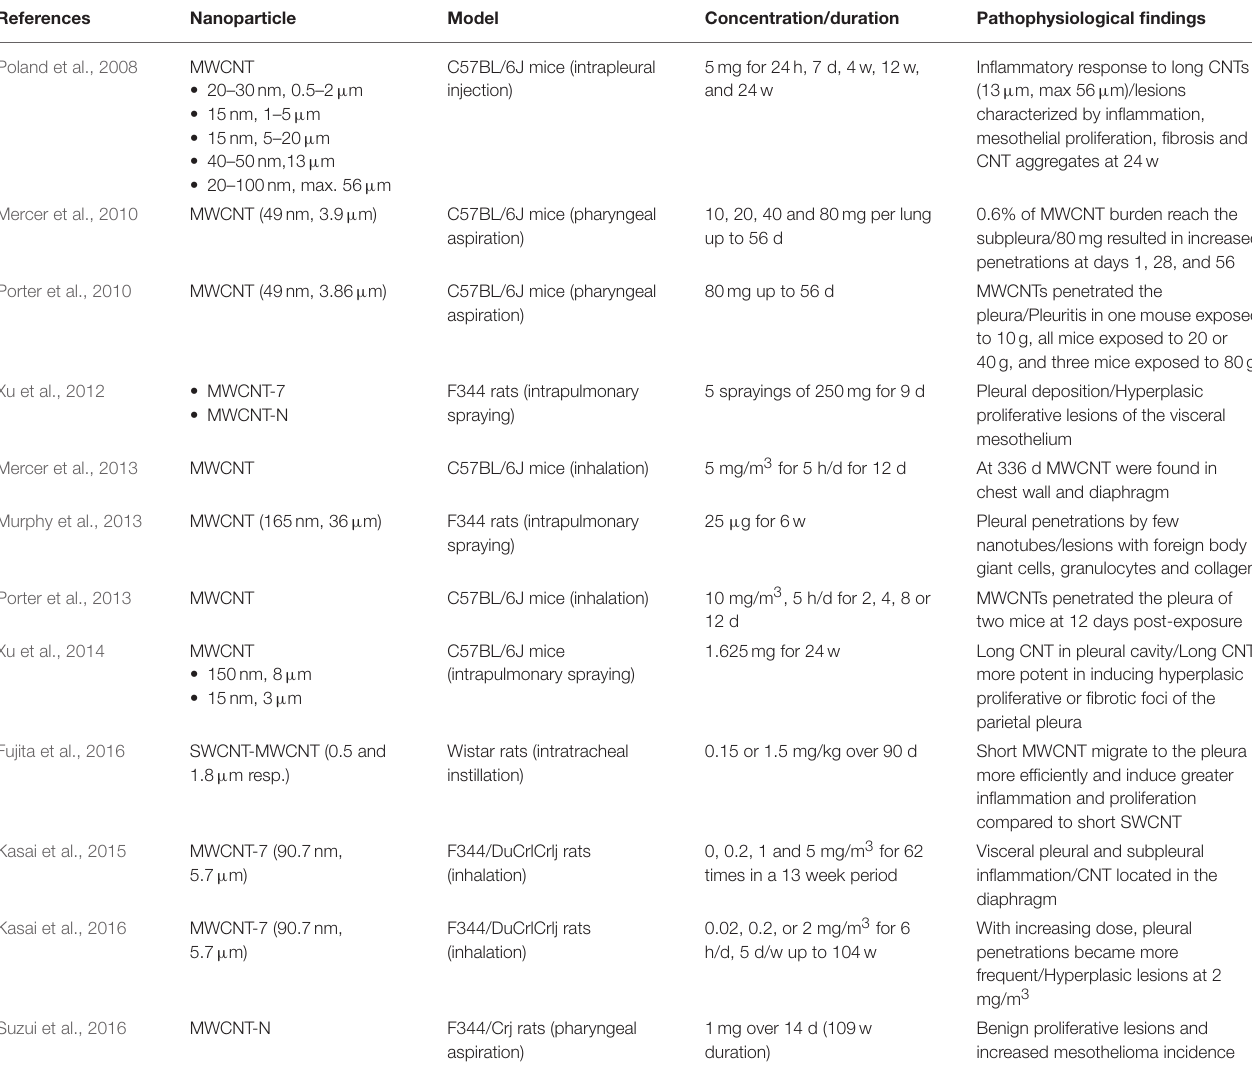
TABLE 2 | CNT associated serosal toxicity after respiratory system exposure (day = d, week = w, month = mo, year =